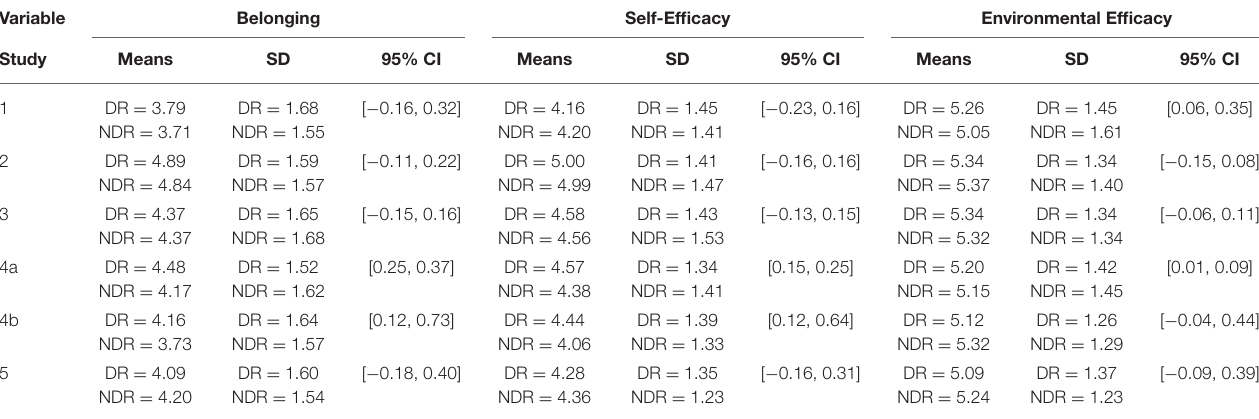
TABLE 9 | Mean, standard deviation, and 95% CI scores obtained for representation for all the studies. Variable Belonging Self-Efficacy Environmental